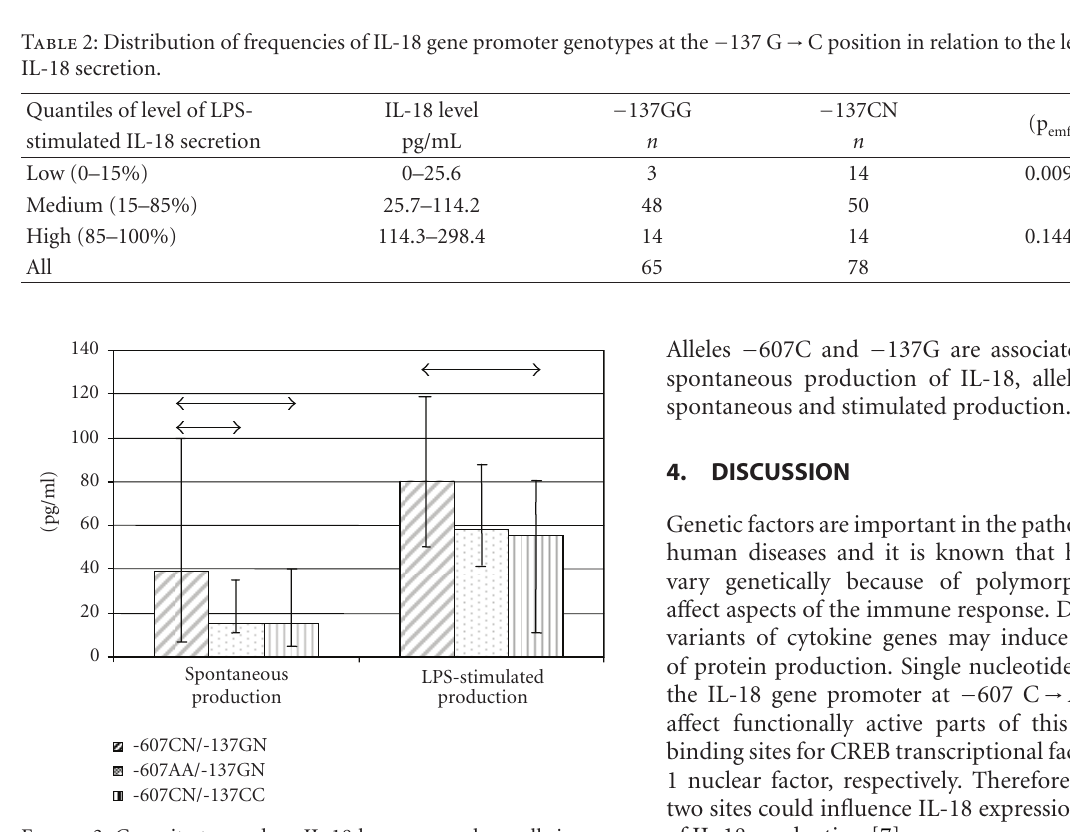
Figure 3: Capacity to produce IL-18 by mononuclear cells is asso- ciated with − 607/ − 137 IL-18 polymorphism (data are represented as median and 25 and 75 percentiles) ( ↔ p